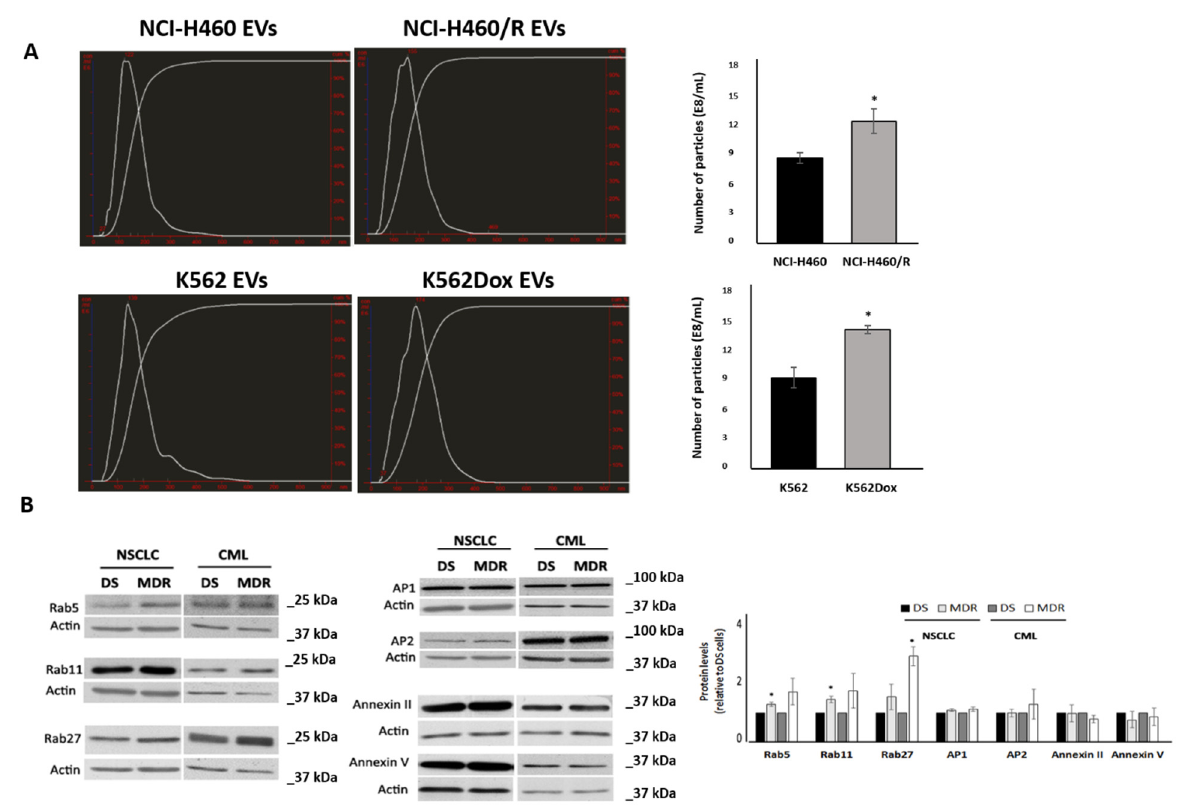
Figure 1. Analysis of EVs release by drug-sensitive (NCI-H460 and K562) and MDR (NCI-H460/R and K562Dox) counterpart cells. ( A ) Comparison of the number of EVs released, estimated by NTA measurements of EVs preparations. Left panel: NTA profile of EVs; right panel: quantification of number of particles normalised to the number of donor cells. * p ≤ 0.05. ( B ) Comparison of the levels of proteins associated to the release of EVs between drug-sensitive (DS: NCI-H460 or K562) and MDR (NCI-H460/R or K562Dox) counterpart cells, analysed by Western blot. Left panel: Representative blots from at least 3 independent experiments; right panel: densitometry analysis expressed after normalisation of the values obtained for each protein with the values obtained for actin (and further expressed in relation to drug-sensitive (DS) cells). * p ≤ 0.05.